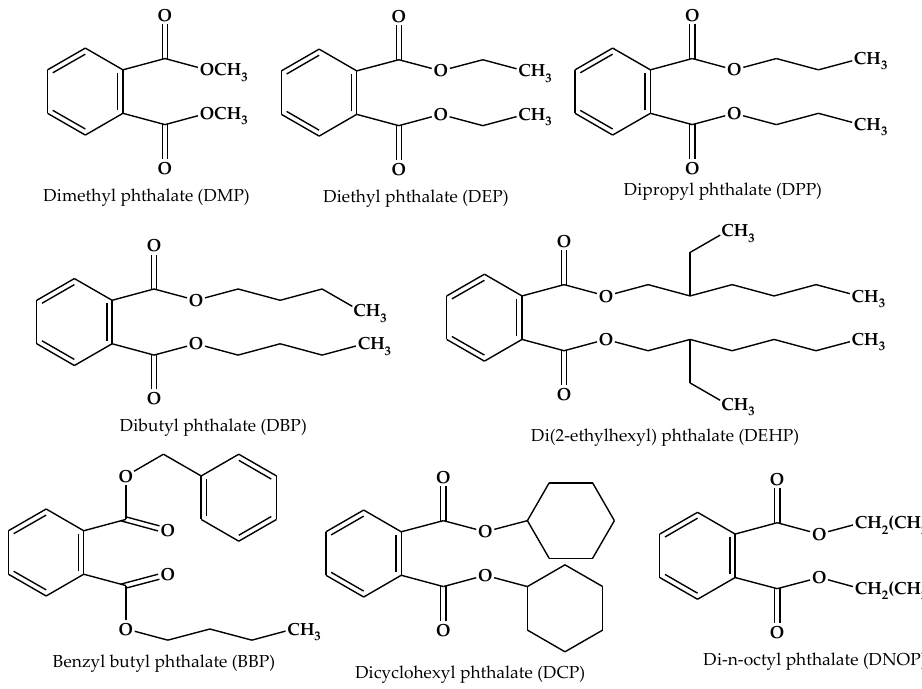
Figure 1. Phthalates used in this